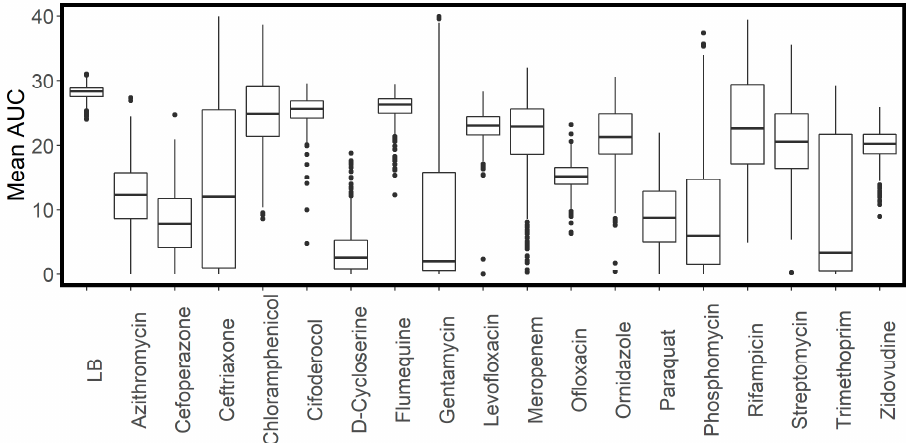
Figure 3. Box and whisker plot showing distribution of mean area under the curve (AUC) for growth of the transporter library in LB and antimicrobial compounds.